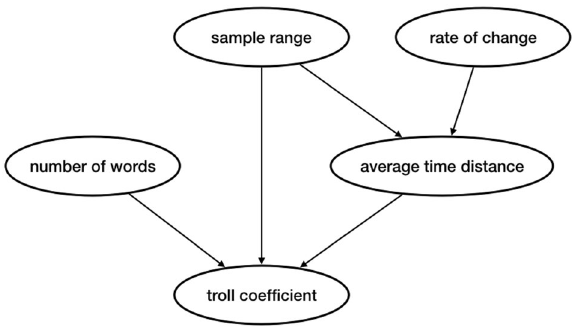
Fig. 3 Causal diagram of the app reviews model. Table 1 Troll coef fi cients and average time distances correlation for training data.